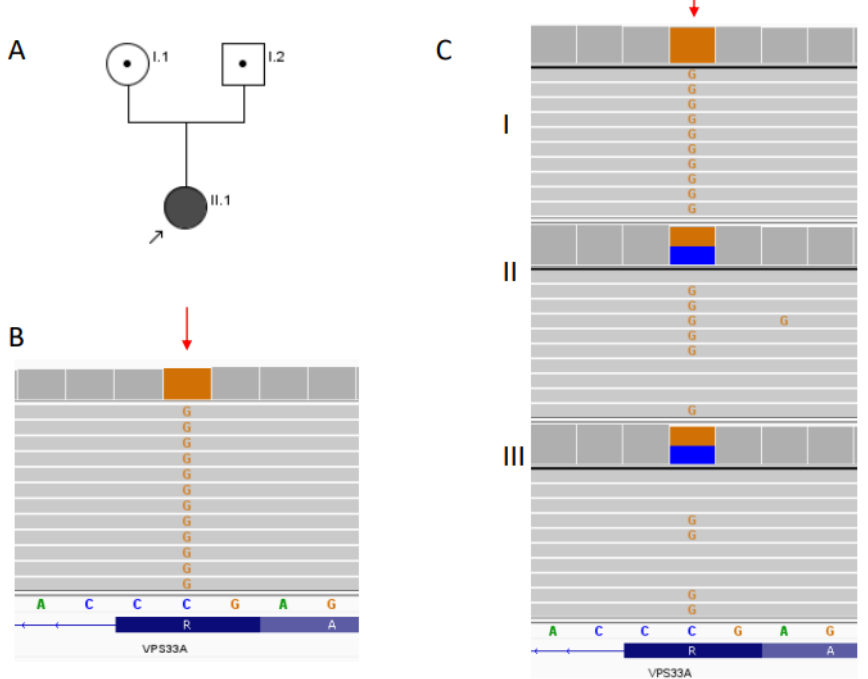
Figure 1. Pedigree of the studied family ( A ), results of WES in the proband ( B ), results of deep amplicon sequencing in the proband and her parents ( C ): I —proband, II —mother, III —father. Red arrows indicate c.599 position in VPS33A gene.